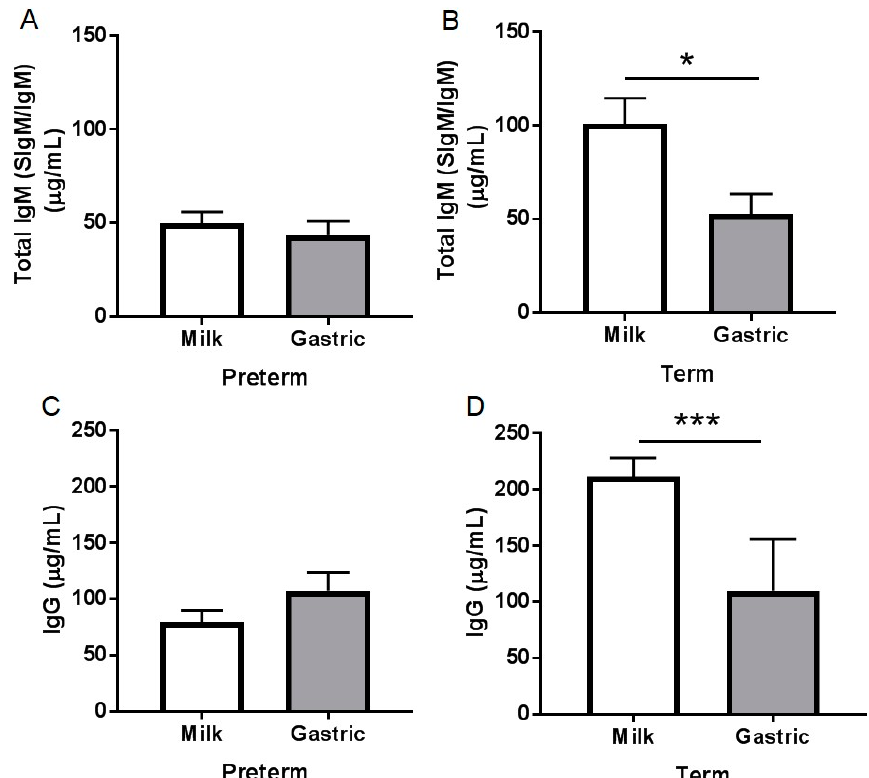
Figure 2. Immunoglobulin concentrations in human milk and gastric samples at 2 h postprandial time